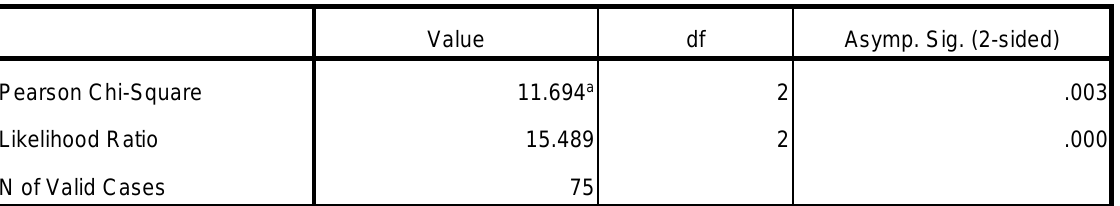
Table 3: Chi-Square